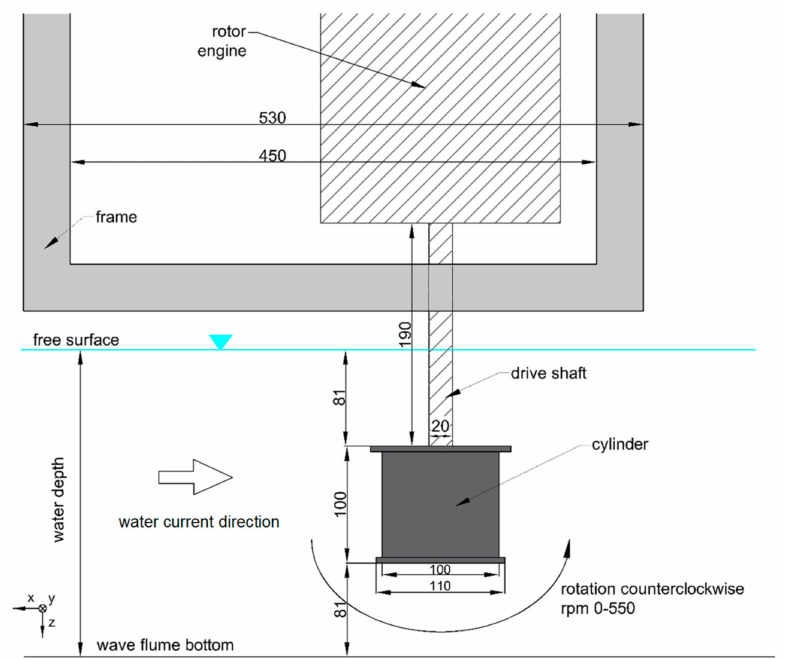
Figure 4. Location of the rotor, rotor drive, and supporting frame in the wave